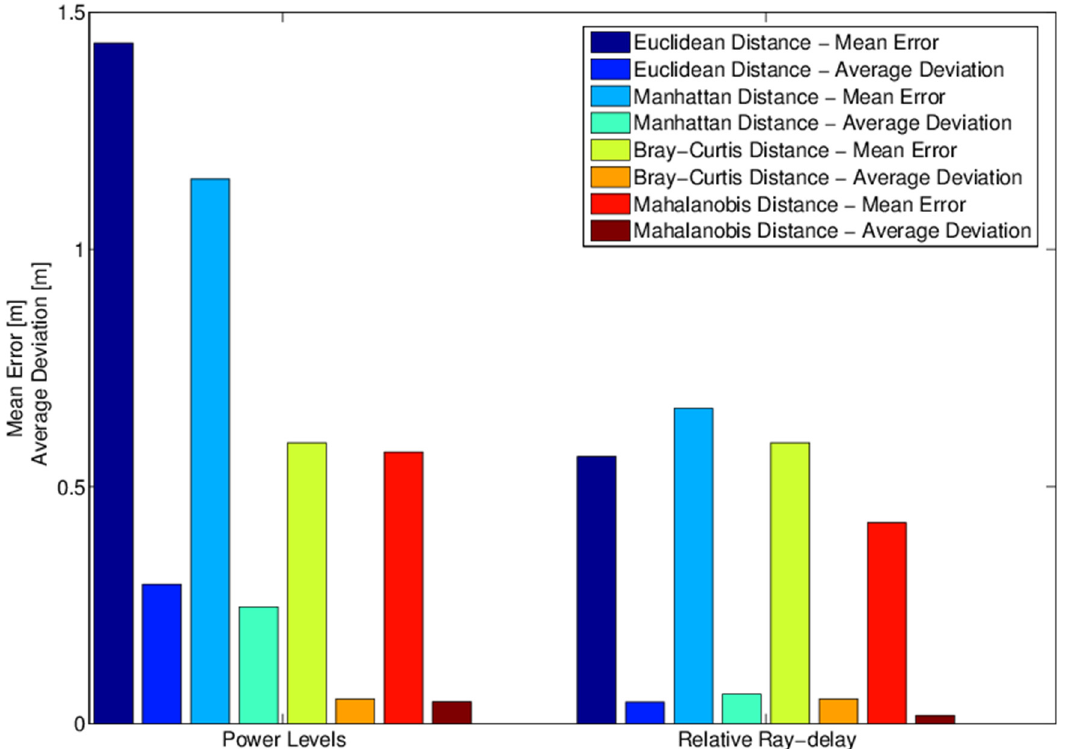
Figure 17. Case 2 results: Localization error when comparing power vs. delay detection methods with four distance metrics in a section of 80 × 80 m.